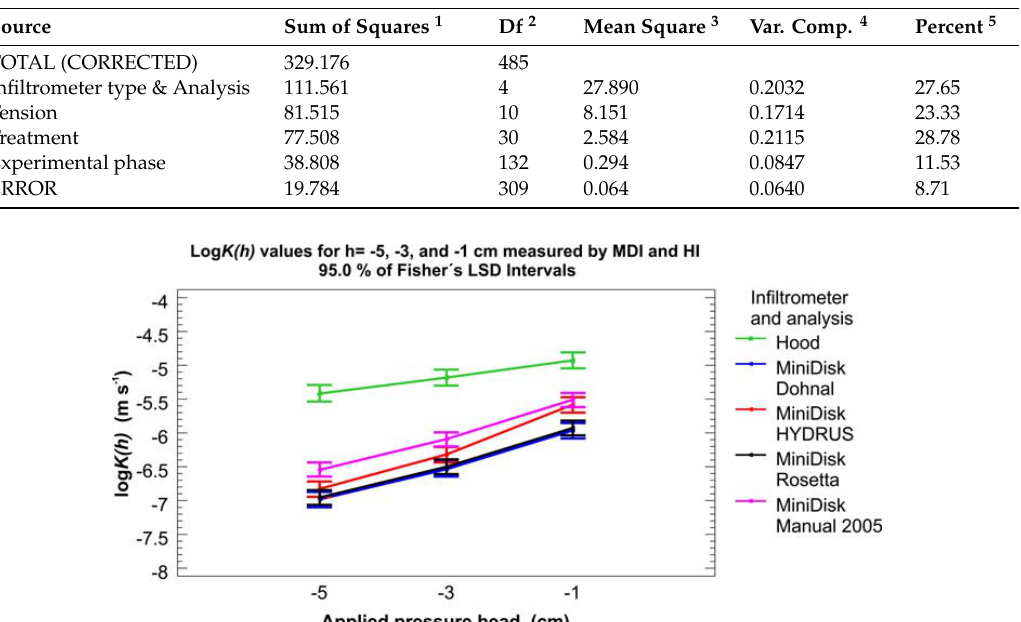
Figure 4. ANOVA results for log K ( h ) data measured by MDI and HI on CT, RT an NT plots. NT, RT and CT are representing No-tillage, Reduced-tillage, and Conventional-tillage treatments of soil.